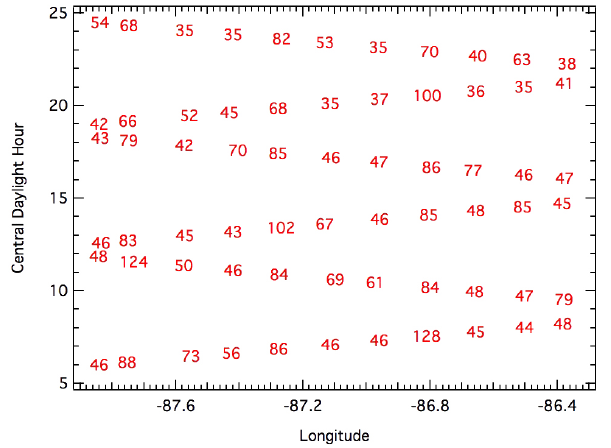
Figure 10. Statistical data for CMAQ model and ferry measurement comparison. Each model grid value and observation averages were binned according to model west–east grid number and time (CDT) of the ferry transect. The 1min O 3 observations were averaged over model grid and hourly output. The numbers here are the number of hourly comparisons between model grid values and hourly averaged O 3 observations via ferry.